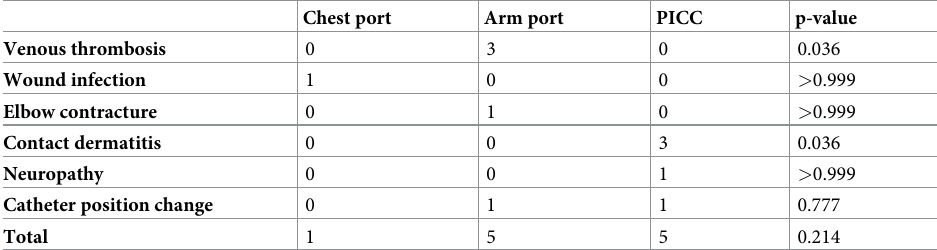
Table 2. Complications.